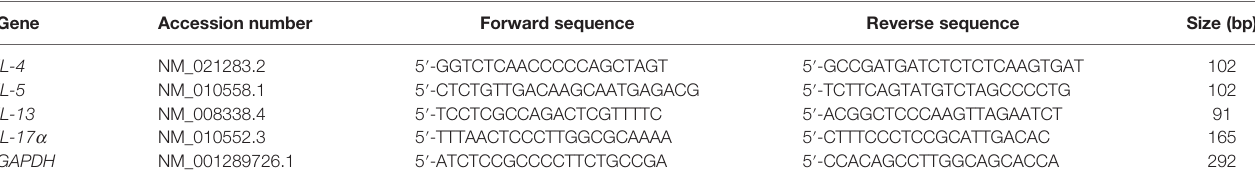
TABLE 1 | List of primers used for gene expression detection